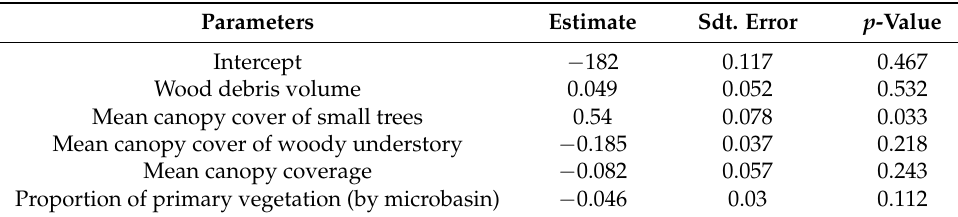
Table 2. Results of General Linear Mixed Model (GLMM) evaluating the effects of structural phys- ical variables of streams on the phylogenetic diversity of the Odonata community (sesPD) in the Brazilian Amazon.